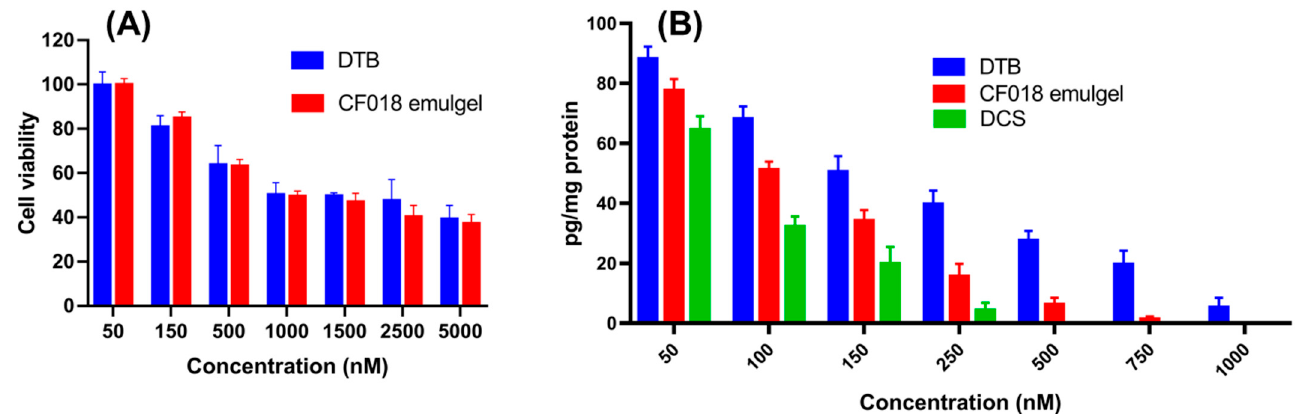
Figure 9. In vitro cell culture studies. ( A ) Cell viability study. ( B ) TNF- α expression level.